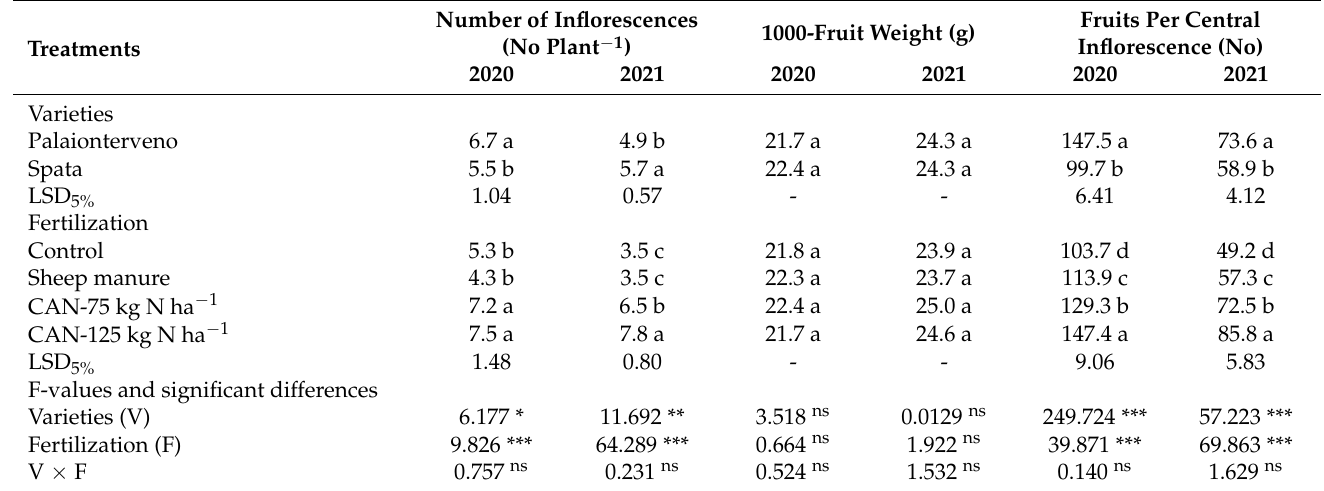
Table 4. Effects of two milk thistle varieties (Palaionterveno and Spata) and fertilization regimes (sheep manure and inorganic fertilizer) on yield parameters (number of inflorescences, 1000-fruit number, and fruits per central inflorescence) of milk